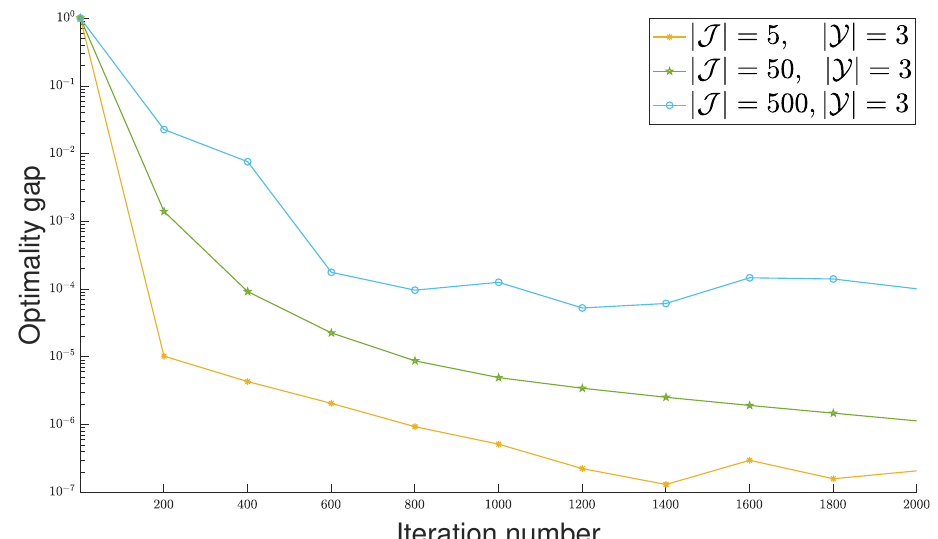
Figure 7. The Impact of the number of source data flows on the convergence.